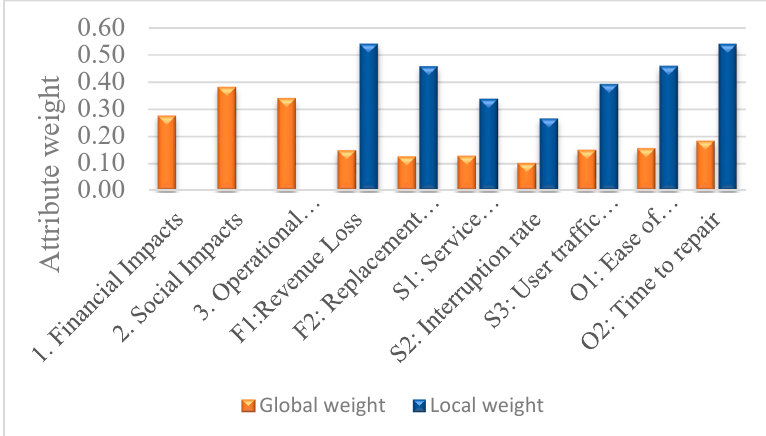
Figure 4. Failure impacts Local and Global Weights Plot.